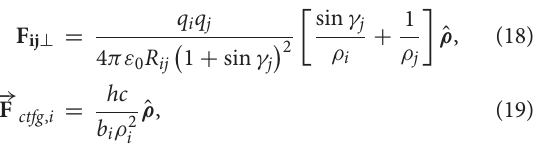
FIGURE 3 | Geometric diagrams. (A) The influence of electromagnetic fields due to triolet T j onto T i : let triolets T i and T j belong to the same component (envelope or nucleus). Triolet T j rotates at light velocity along circular orbit of radius ρ j and arrives at angle θ j at time t , but was at position T j ’ at retarded angle θ j ’ and time t’ when it emitted electromagnetic fields that reached triolet T i revolving along coplanar circular orbit of radius ρ i and arriving at angle 0 (vertical y axis) at time t . The retarded electromagnetic fields can be expressed using Liénard-Wichert potentials. This figure applies to all envelope and nucleus triolets. (B) Diagram showing vectors and angles involved in the demonstration of the expressions of electromagnetic fields and potentials. (C) Diagram depicting the case ρ j = ρ i